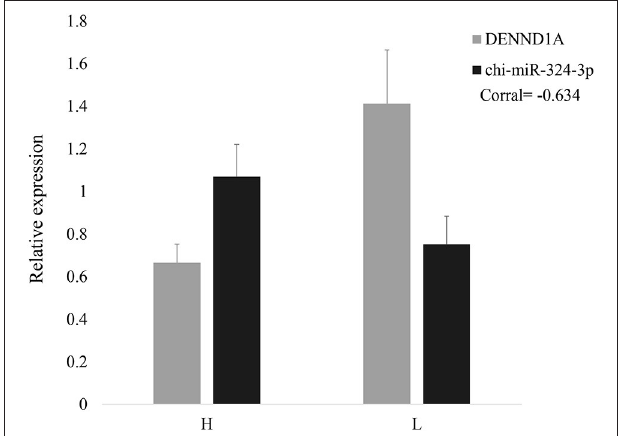
FIGURE 1 | Relative expressions of DENND1A and chi-miR-324-3p in goat ovarian tissues in high- and low-yielding groups. H represents the high-yielding group; L represents the low-yielding group.